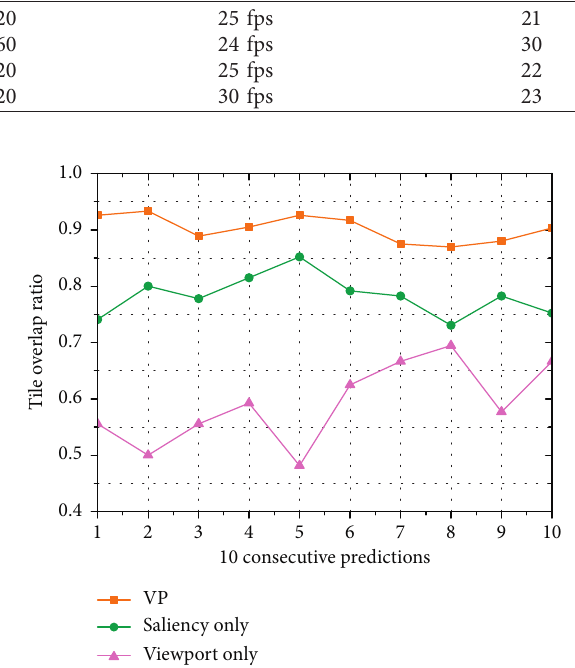
Figure 6: Example result of 10 consecutive predictions, with an � interval time t 0